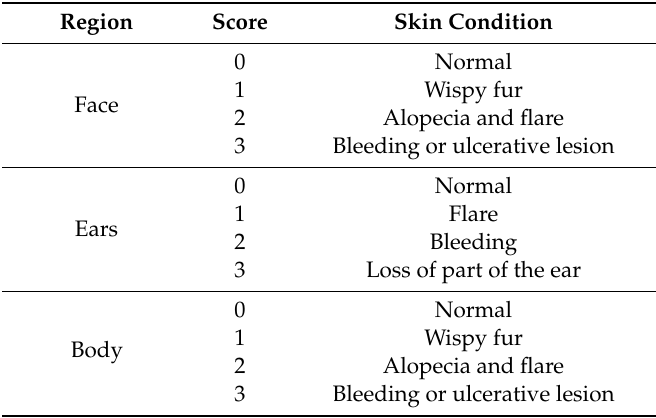
Table 4. Evaluation of the cutaneous